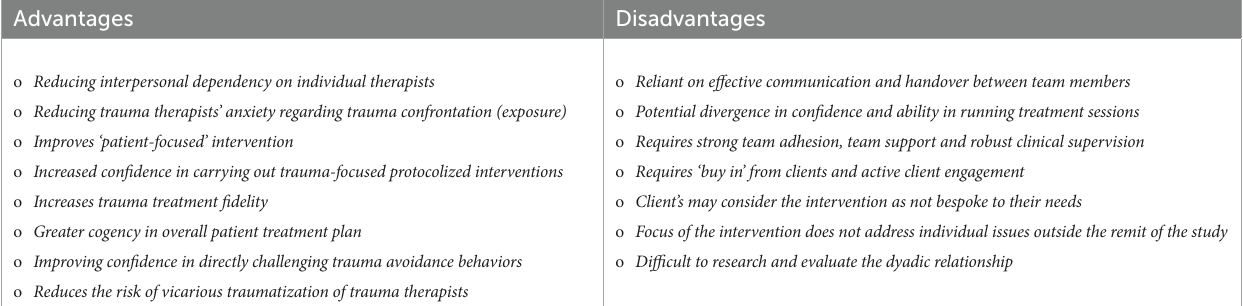
TABLE 2 Advantages and disadvantages of therapist rotation model in EMDR